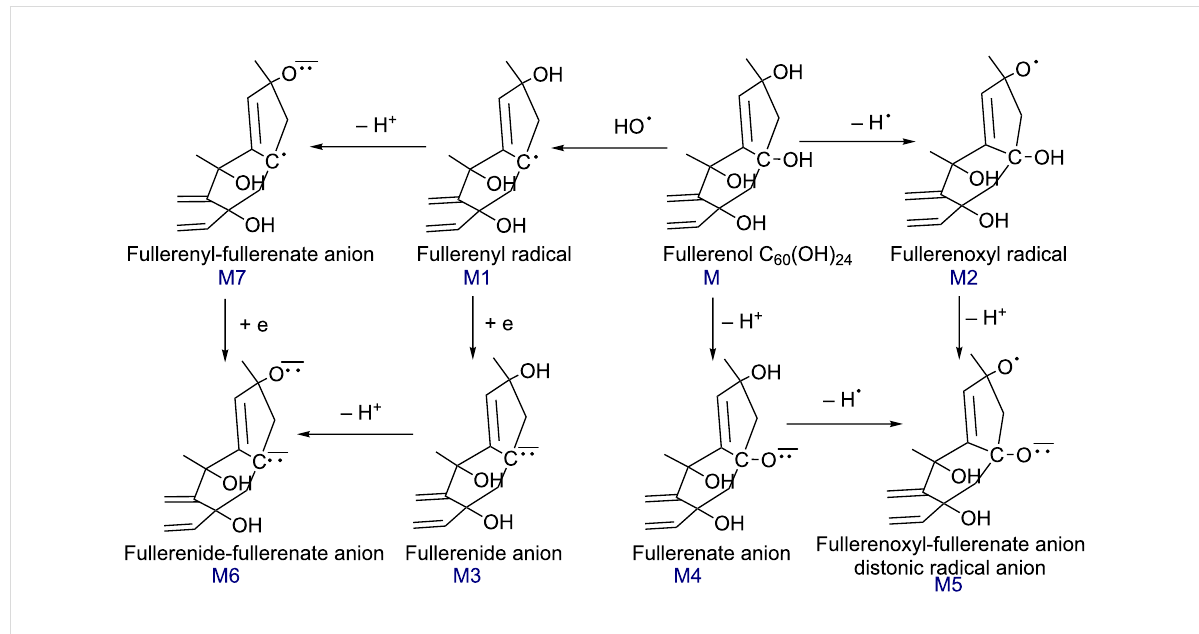
Scheme 1: Proposed mechanisms for the formation of fullerenol anions and distonic radical anions observed by ( − )ESI-MS spectra of C 60 (OH) 24 in pure